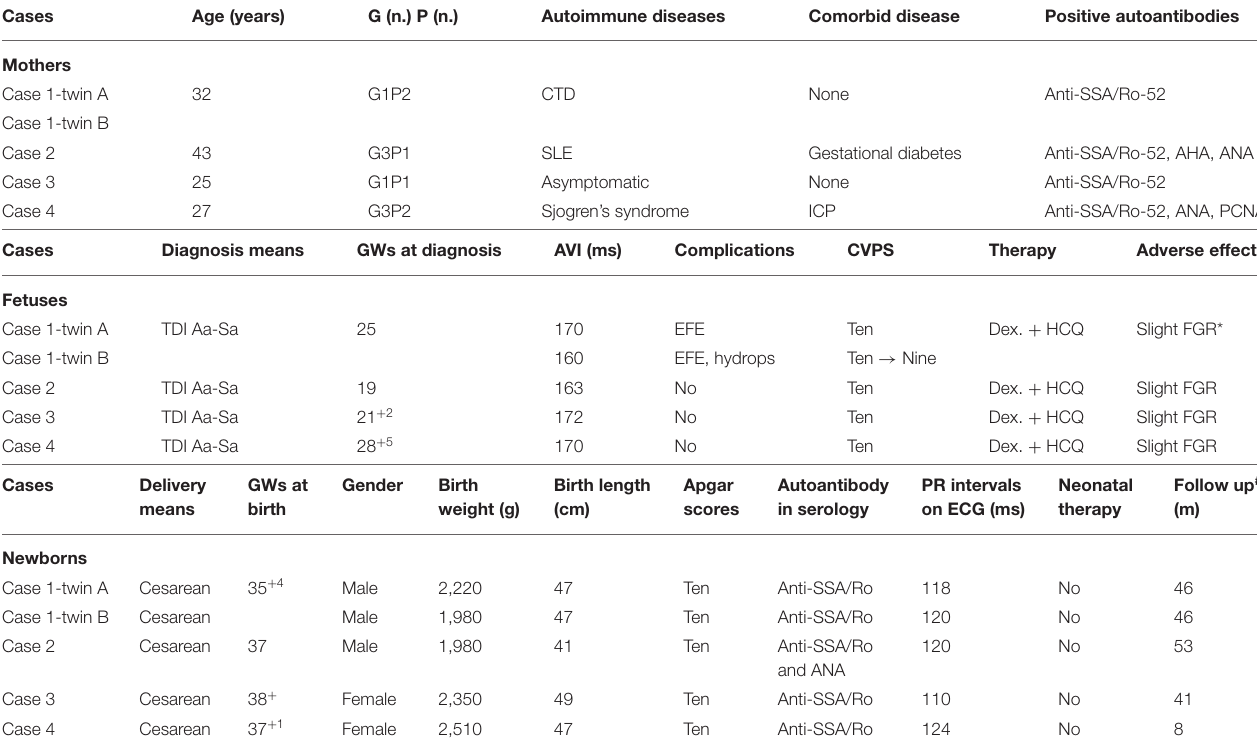
TABLE 1 | Clinical characteristics of five fetuses with fetal autoimmune-associated first-degree AVB in our center.